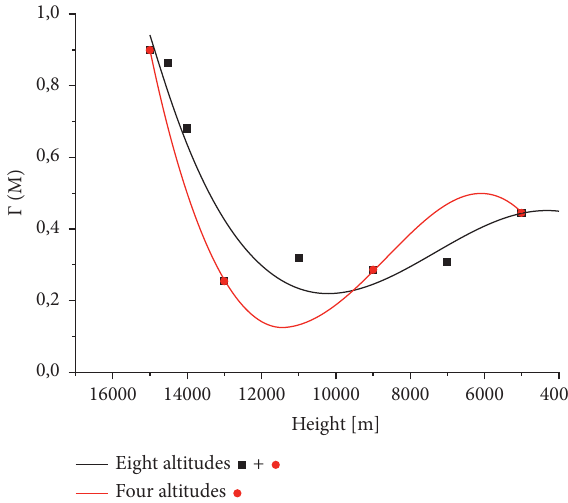
Figure 4: Comparison of the obtained curves for different selection of altitudes for the fragment no. 21 (208 g with orientation in the X axis direction, polynomial fit of the 3rd degree for default four altitudes (red curve) and for selected eight altitudes (black